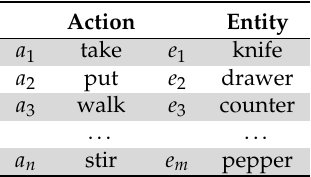
Table 1. Result of step 1: A dictionary of actions and